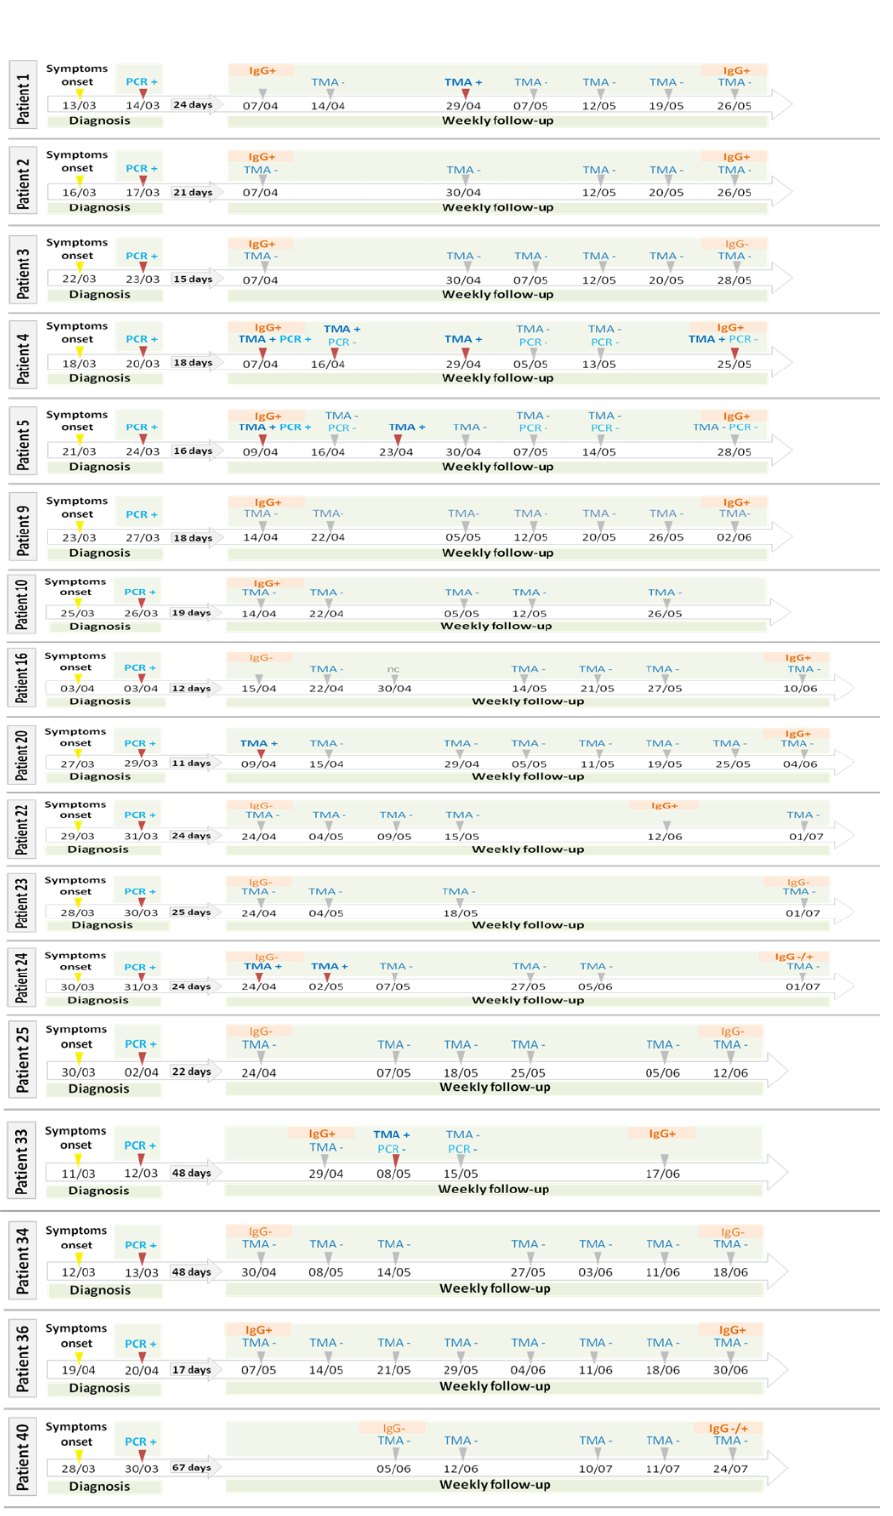
Figure 1. Timeline of participants with no evidence of newly acquired infection or early probable reinfection in the IC cohort. TMA: transcription-mediated amplification, PCR: polymerase chain reaction.